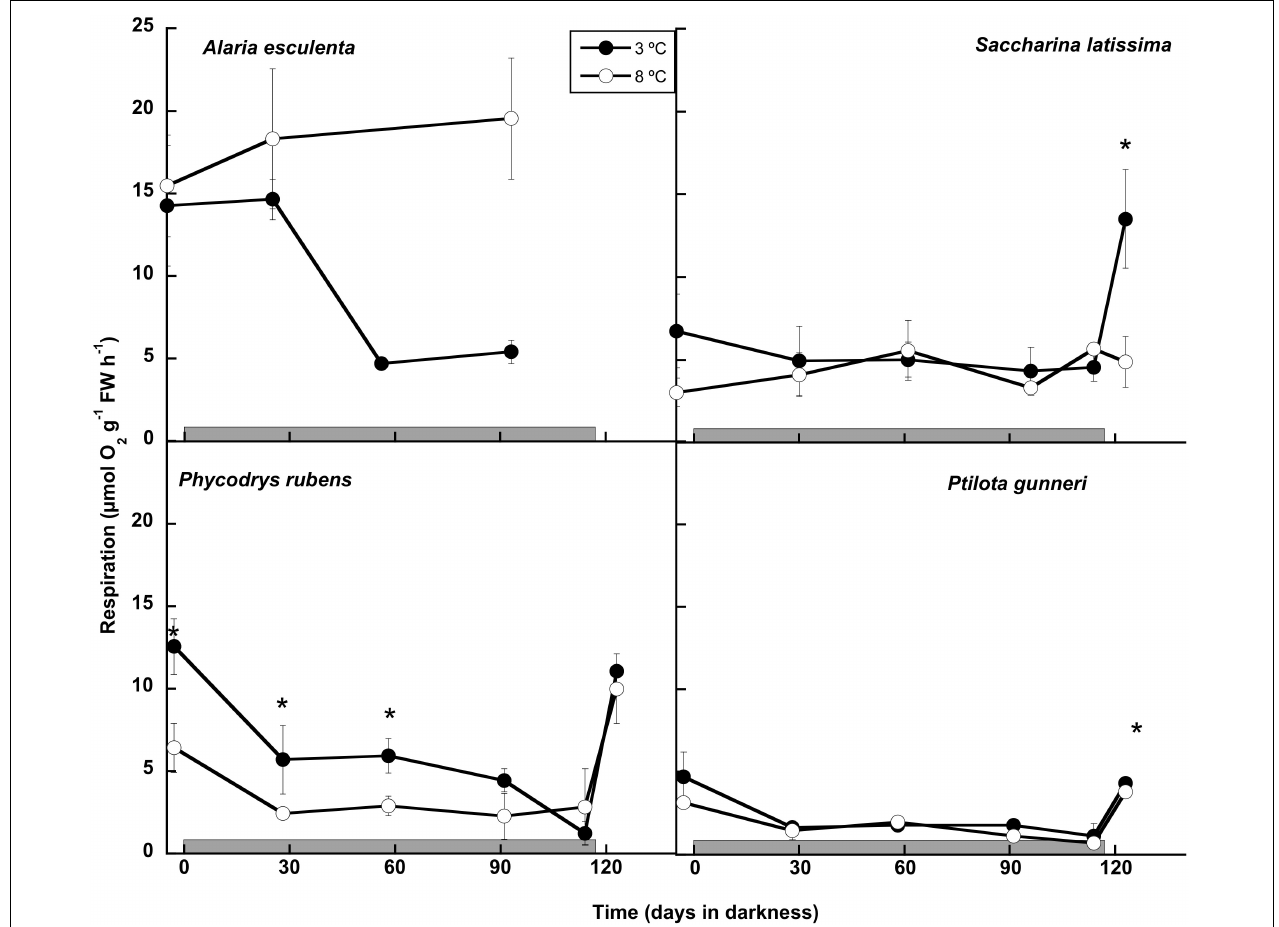
FIGURE 3 | Respiration rate measured as O 2 consumption during the 16 weeks of incubation in darkness (gray horizontal bar) of Alaria esculenta , Saccharina latissima , Phycodrys rubens , and Ptilota gunneri at two different temperatures. Data are mean of 3 replicates (error bars for standard deviation). Significant differences between temperatures marked with an